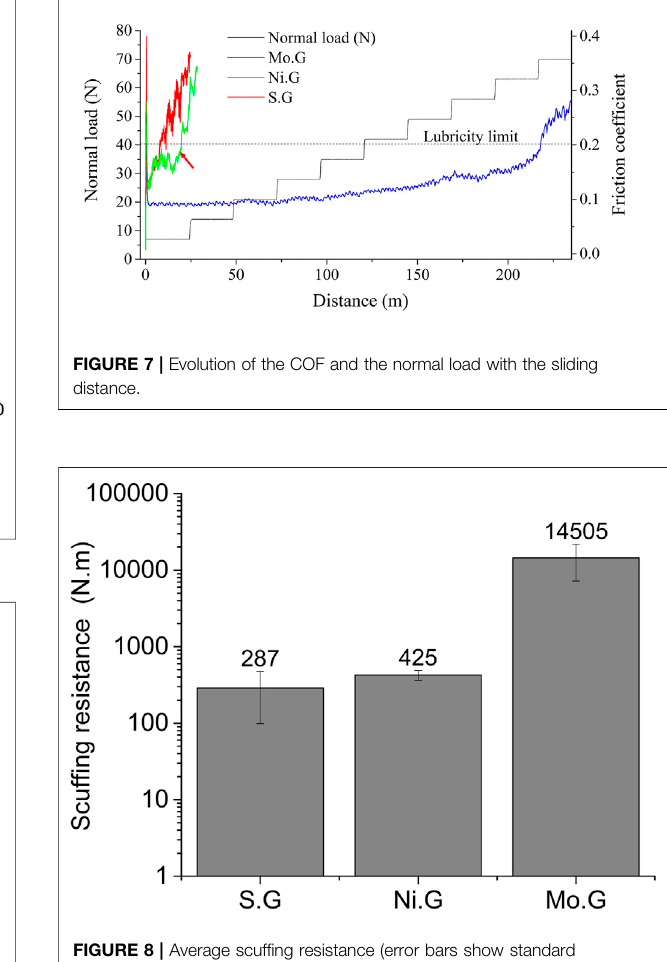
FIGURE 8 | Average scuf fi ng resistance (error bars show standard